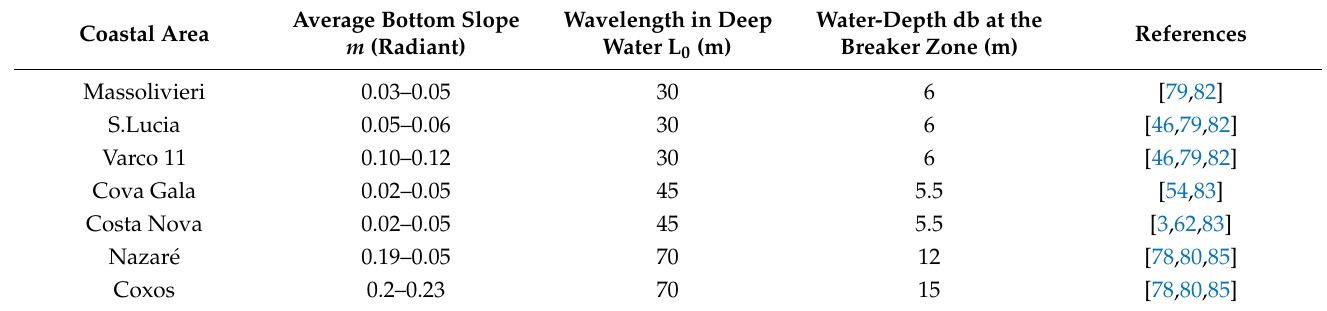
Table 3. Parameters used for the assessment of breaking-wave height at the offshore conditions. Average bottom slope m was obtained through available bathymetric surveys. The water depth at the breaker zone was derived from literature [78,82–85]; wavelength in deep water was assessed from the SWAN model (reported in Scicchitano et al. [35]) and wave model of Spanish Harbor